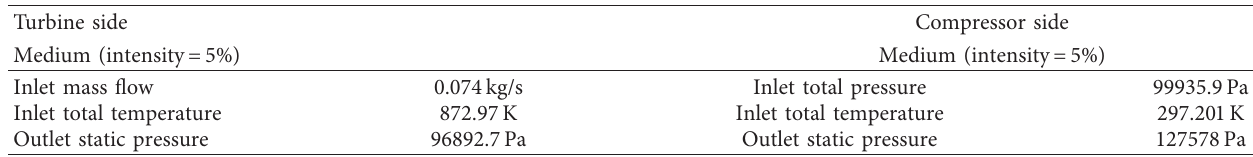
Table 2: The boundary conditions for aerothermal